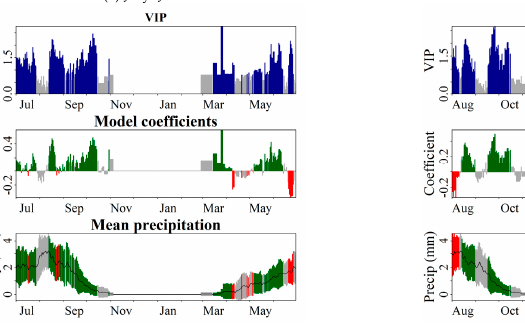
Figure 6. Results of Partial Least Squares (PLS) regression correlating grass biomass in 1997–2011 with 15-day running means of daily effective precipitation during ( a ) July–June, ( b ) August–July and ( c ) September–August. Blue bars indicate that VIP values are greater than 0.8, the threshold for variable importance. Red color means model coefficients are negative and important, while green color indicates important positive relationships between aboveground biomass and precipitation.